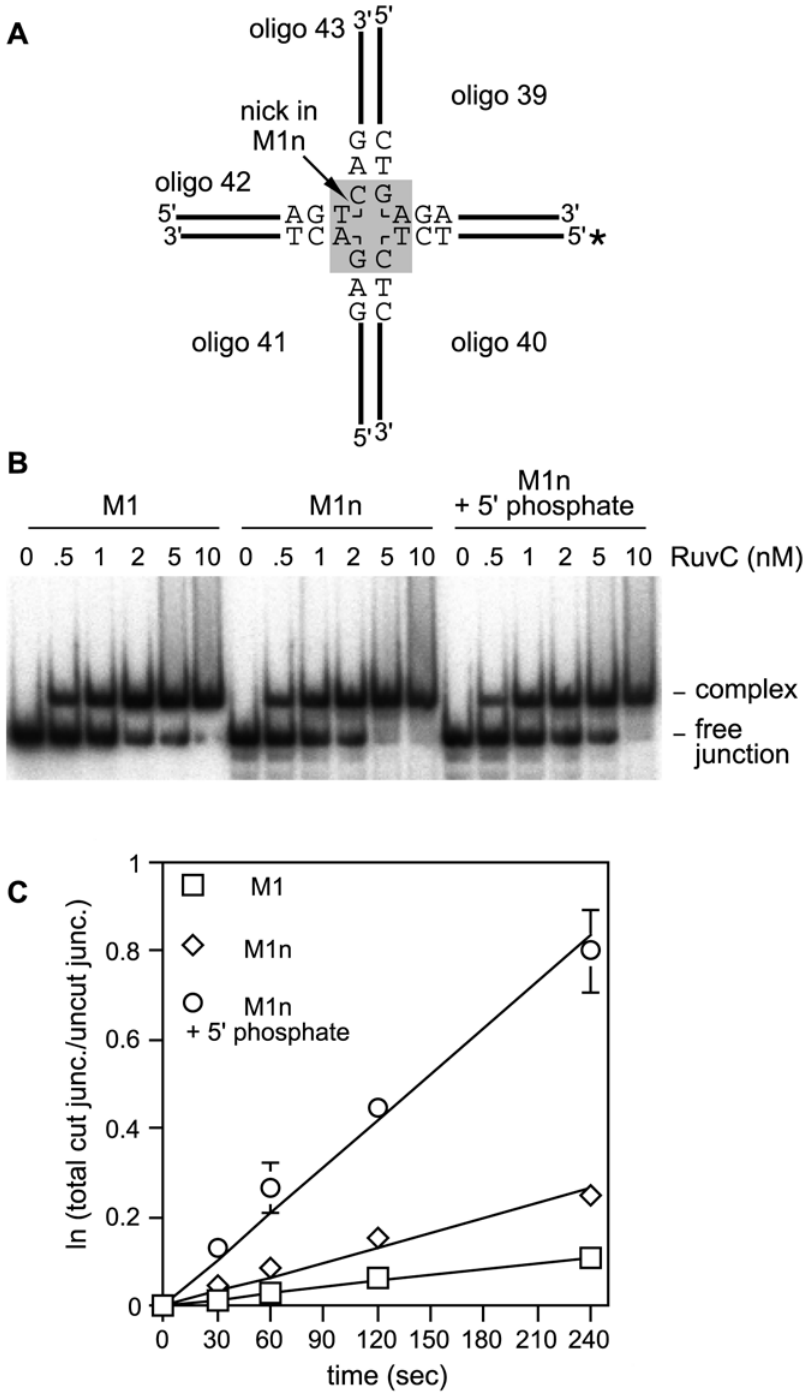
Figure 2. Cleavage of M1 and M1n ( + / 2 5 9 phosphate at nick site) by RuvC. ( A ) Schematic showing the core nucleotide sequences in M1 and M1n. The asterisk indicates the 5 9 32 P label. ( B ) A comparison of RuvC’s binding affinity for M1 and M1n ( + / 2 5 9 phosphate at nick site) by RuvC. Reaction conditions are described in Materials and Methods. ( C ) Single turnover kinetic analysis of M1 and M1n ( + / 2 5 9 phosphate at the nick site) cleavage by RuvC. The reaction conditions are described in Materials and Methods. The data are the means of three independent experiments, and the error bars represent the standard deviations. doi:10.1371/journal.pone.0005347.g002 sufficient for optimal cleavage efficiency. Recently we showed that for nicked HJs is unaffected by the presence of a 5 9 phosphate at the nick site. This correlation between binding affinity and nicked HJs are bound with higher affinity than intact HJs in the presence of a relatively low concentration of divalent metal ion cleavage efficiency contrasts with RuvC, which binds equally well [15]. Similar to cleavage efficiency, the binding affinity of Mus81 to intact and nicked HJs (with and without a 5 9 phosphate at the